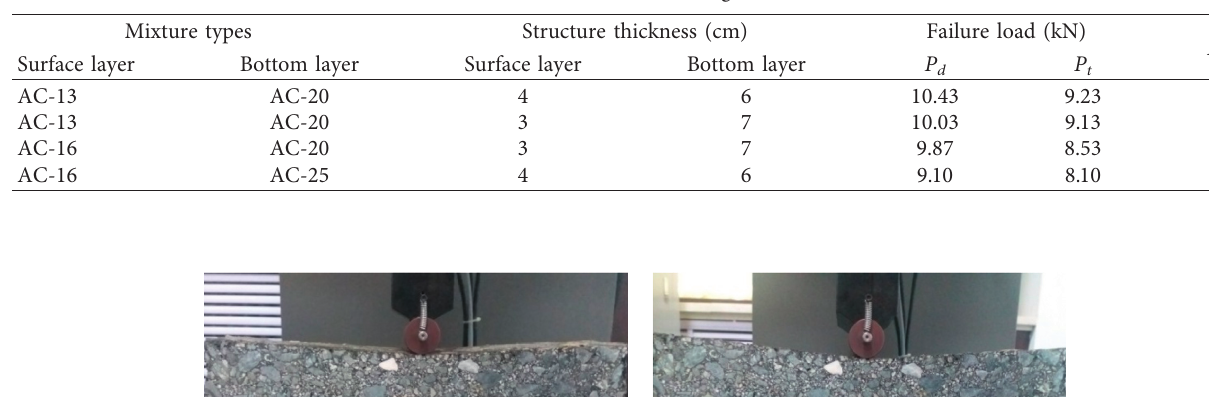
Table 4: Results of the bending beam test.